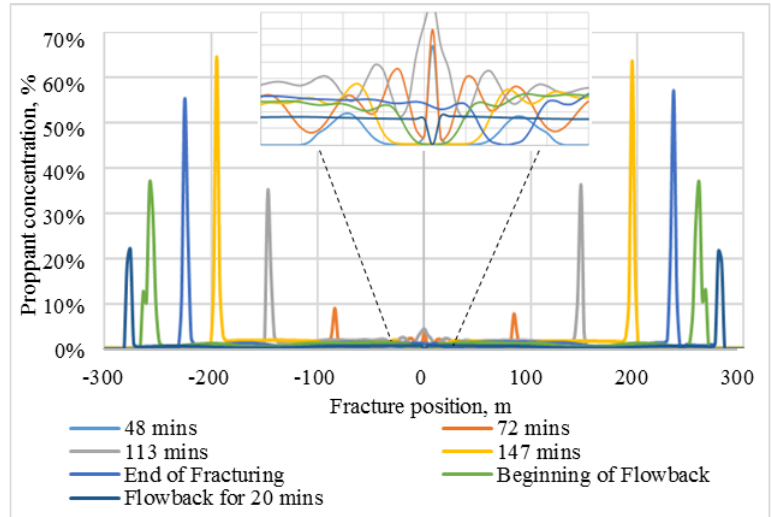
Figure 8—Proppant concentration profiles perpendicular to the fracture in the course of injection and flowback.